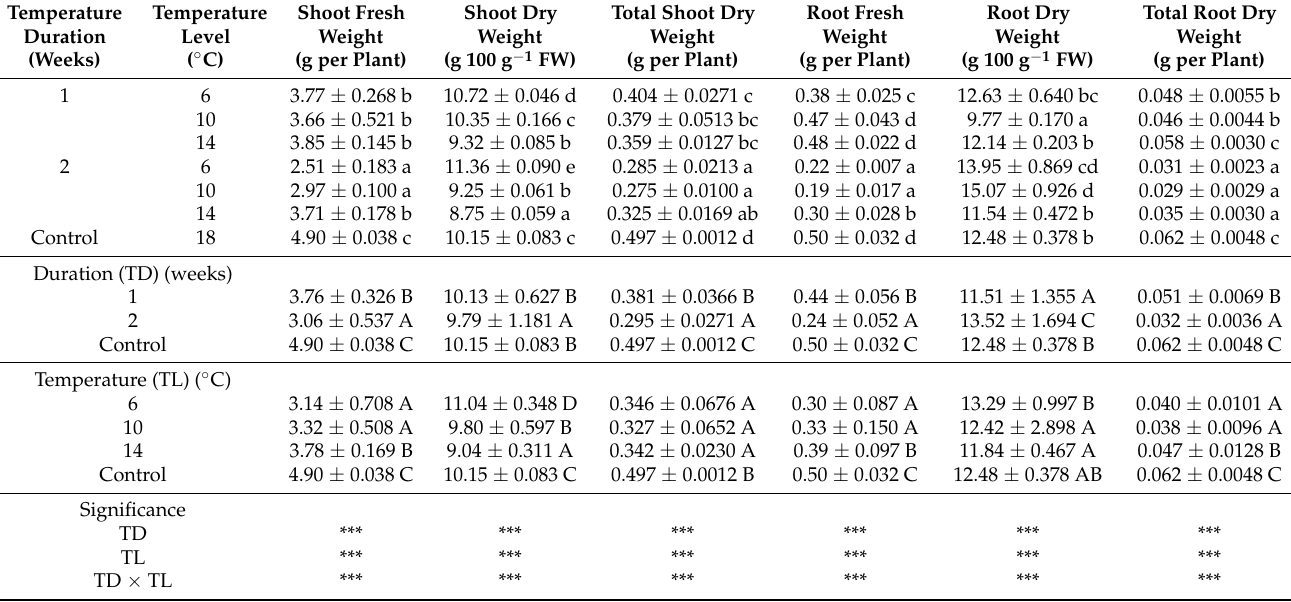
Table 2. Effect of low-temperature treatment on fresh weight and dry weight of broccoli